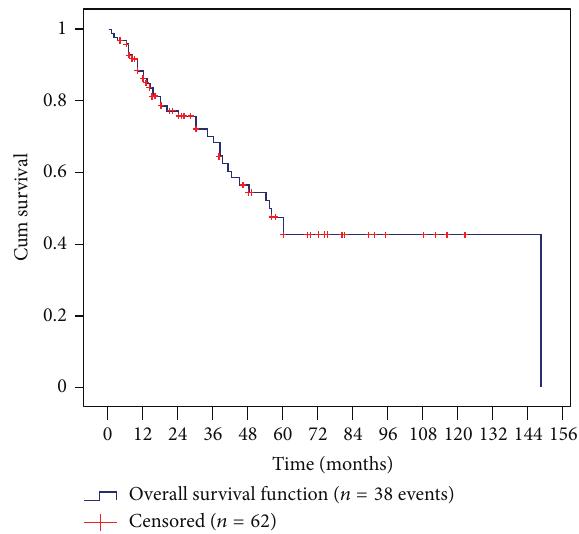
Figure 4: Kaplan-Meier analysis plotting disease-free survival for recurrent (same site) disease and recurrence-free patients ( 𝑃 = 0.0001 , Log-Rank